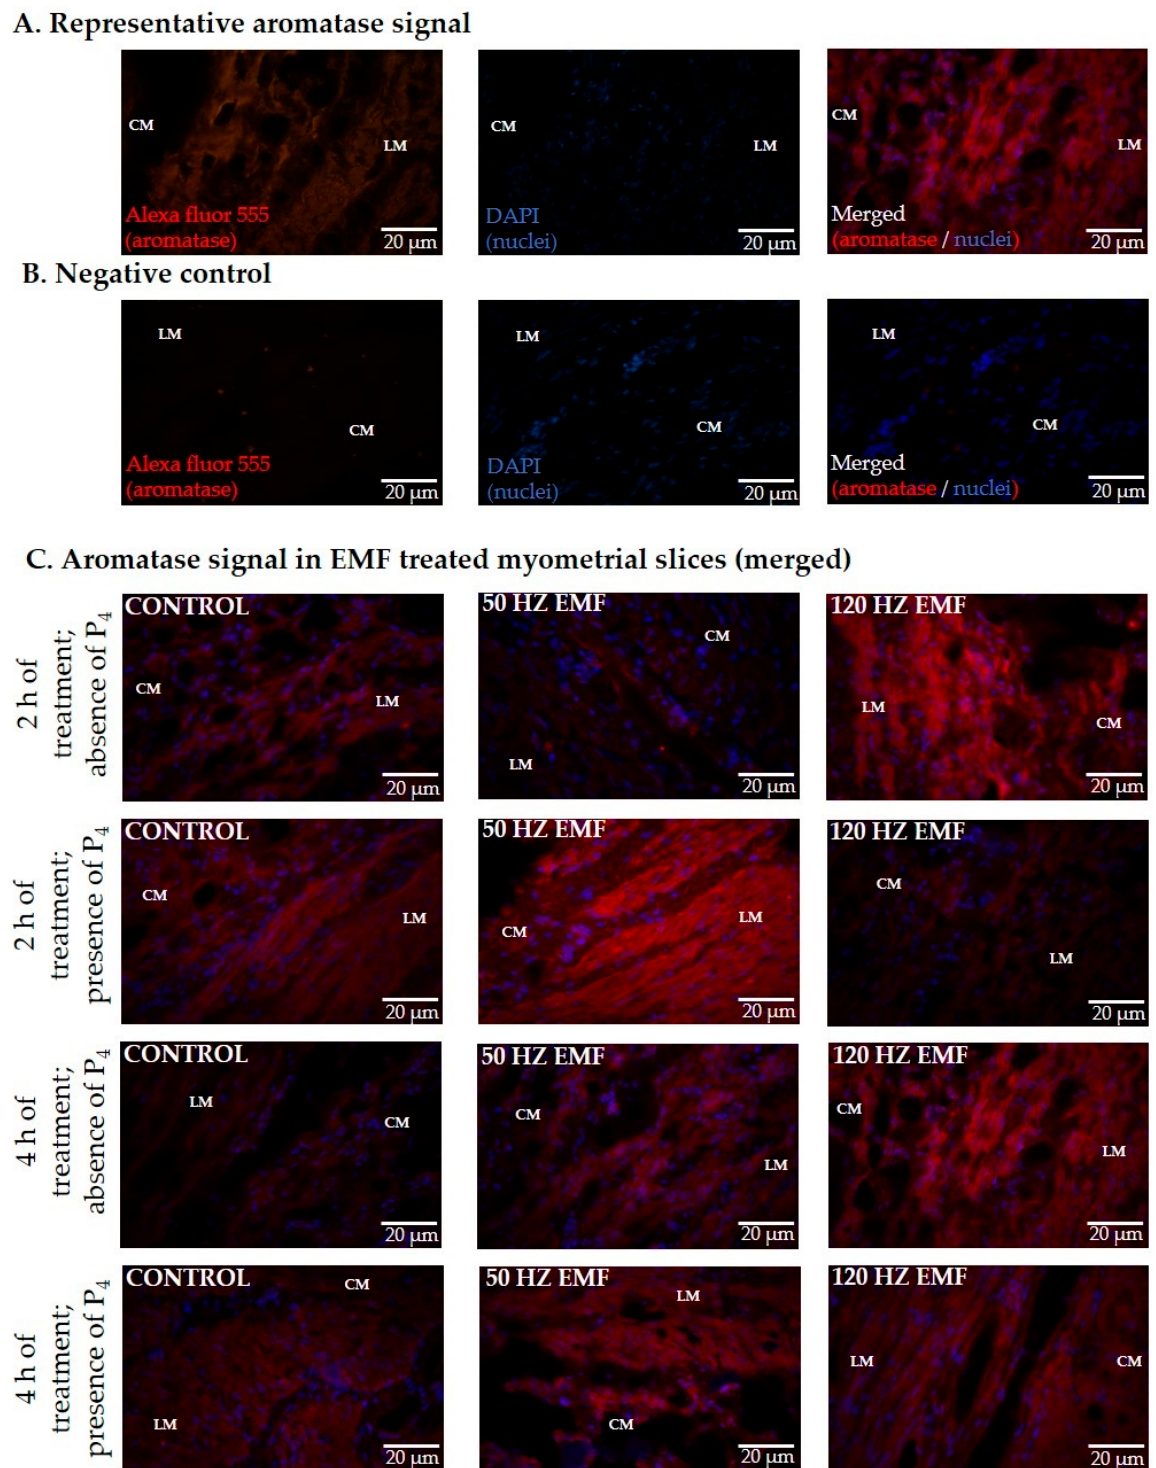
Figure 2. Randomly selected representative photographs of immunodetection of cytochrome P450arom (aromatase) in porcine myometrium of pigs during the peri-implantation period exposed in vitro to an electromagnetic field (EMF) at the frequency of 50 and 120 Hz, for 2 and 4 h in the presence or absence of P 4 . The panels show representative aromatase signal ( A ), negative control ( B ), and aromatase signal in EMF-treated myometrial slices (merged) ( C ). Magnification 400×. CM—circular muscle; LM—longitudinal muscle. The nuclei are stained with DAPI (blue) and binding sites are visualized with Alexa Fluor 555 (red).